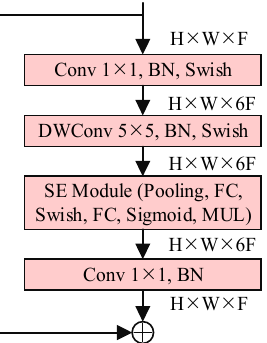
Figure 3. The MBConv6 (k5 × 5) fundamental structure. MBConv represents mobile inverted bottleneck convolution; Conv denotes pointwise convolution; BN denotes batch normalization; Swish denotes swish activation function; DWConv represents depthwise convolution; SE Module represents squeeze-and-excitation module; FC represents fully connected layer; H × W × F represents tensor shape (height, width, depth).